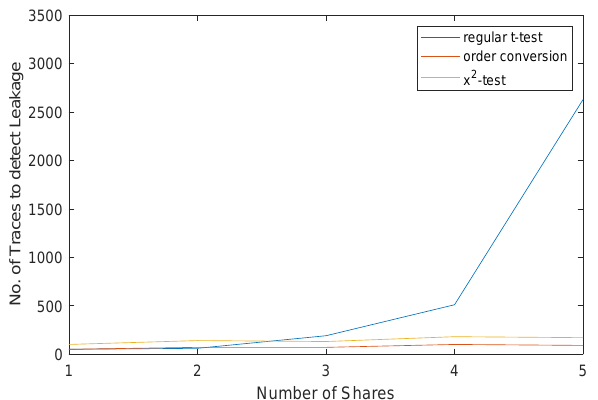
Figure 22: Number of traces to detect leakage for different number of shares using three different methods in Figures 19, 20 and